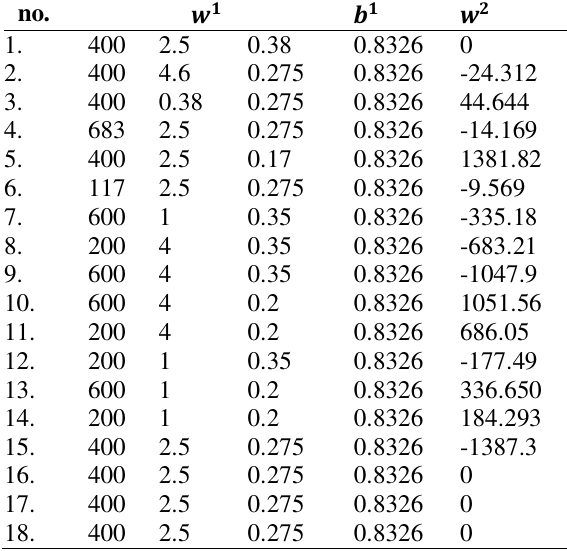
The network weights matrices and & (